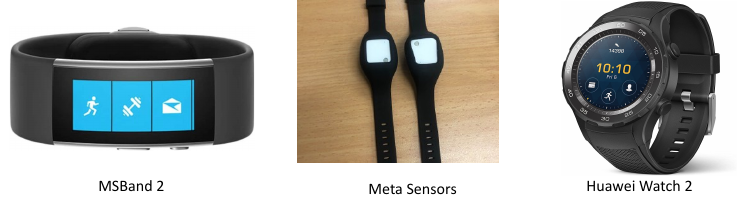
Figure 3. The three different hardware used for data